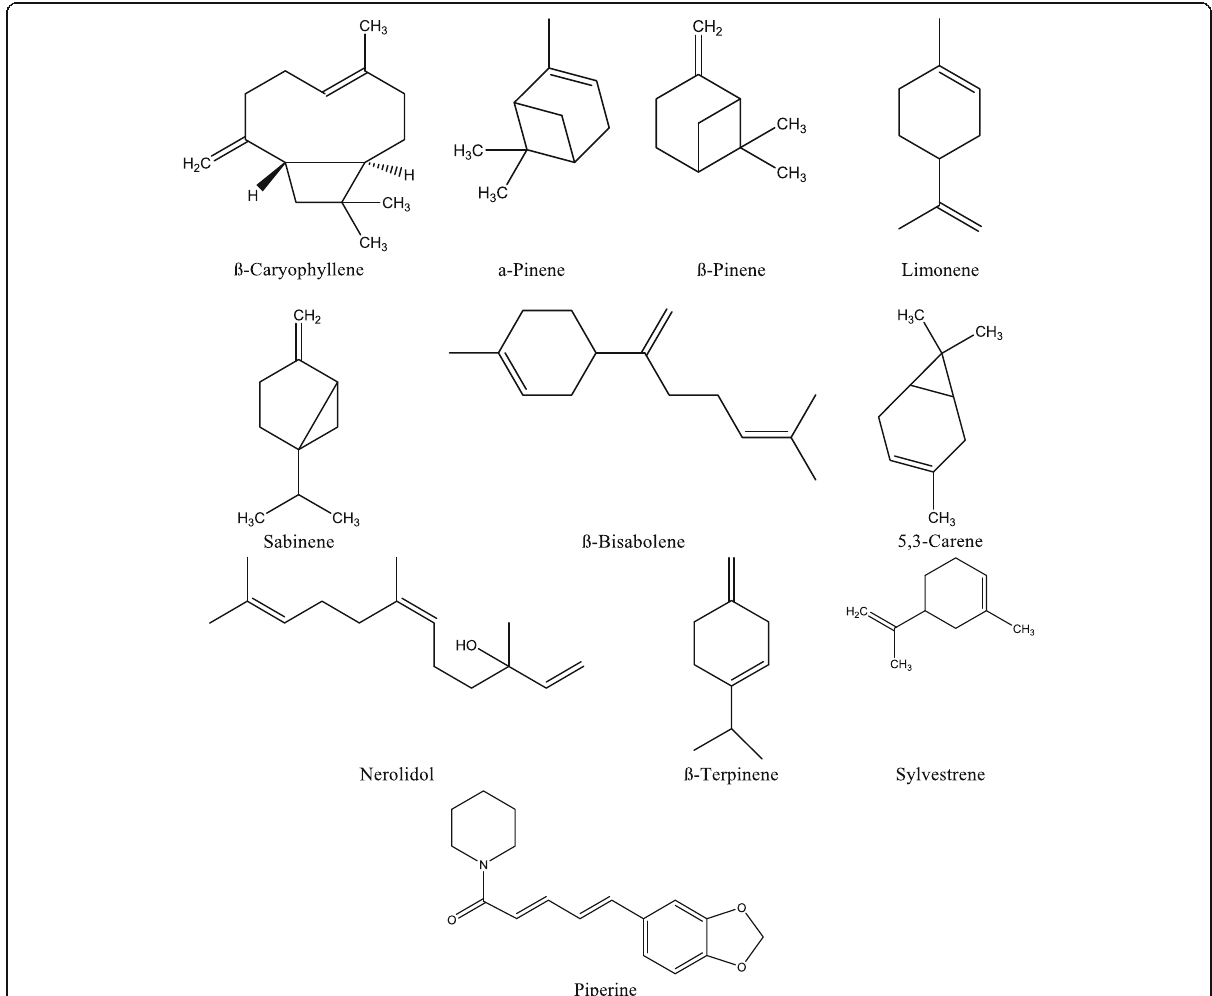
Fig. 2 Molecular structures of piperine and major essential oil constituents from Piper nigrum